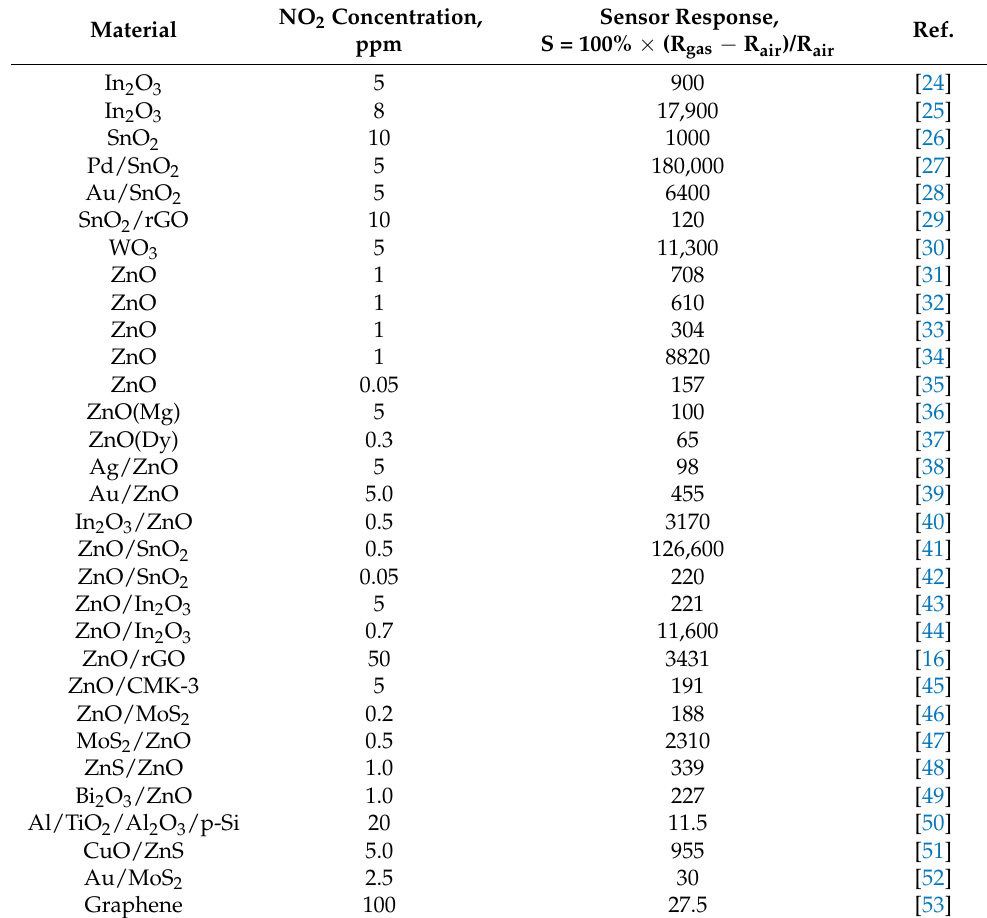
Table 1. Sensor response of various materials when detecting NO 2 under UV photoactivation.